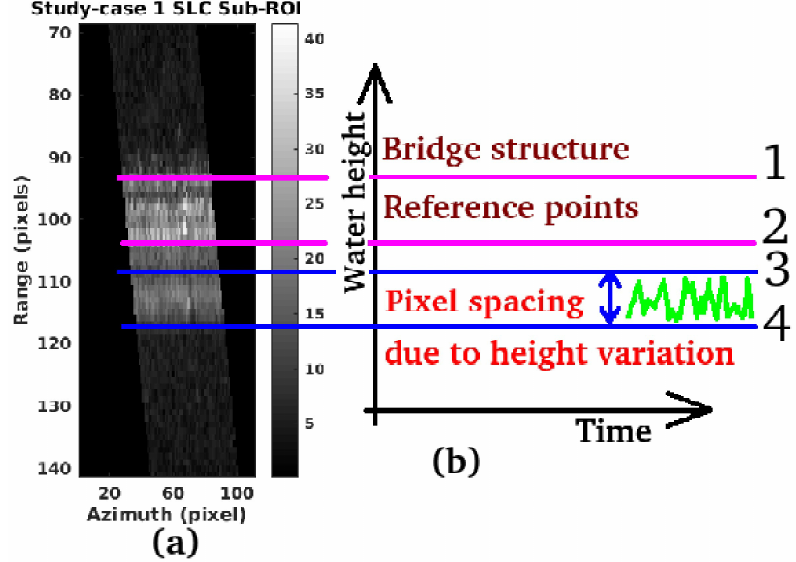
Figure 9. Case study 1 Sub-ROI parameters. ( a ): Sub-ROI SAR image representation in the slant coordinates. ( b ): Scattering parameters on the reference points and pixel spacing